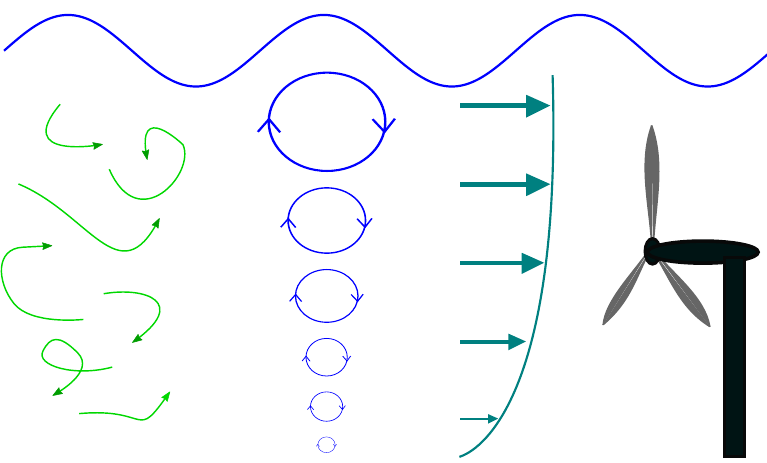
Figure 1. Diagram of the causes of unsteady loads on tidal turbines. Shown from left to right: turbulence, waves and shear